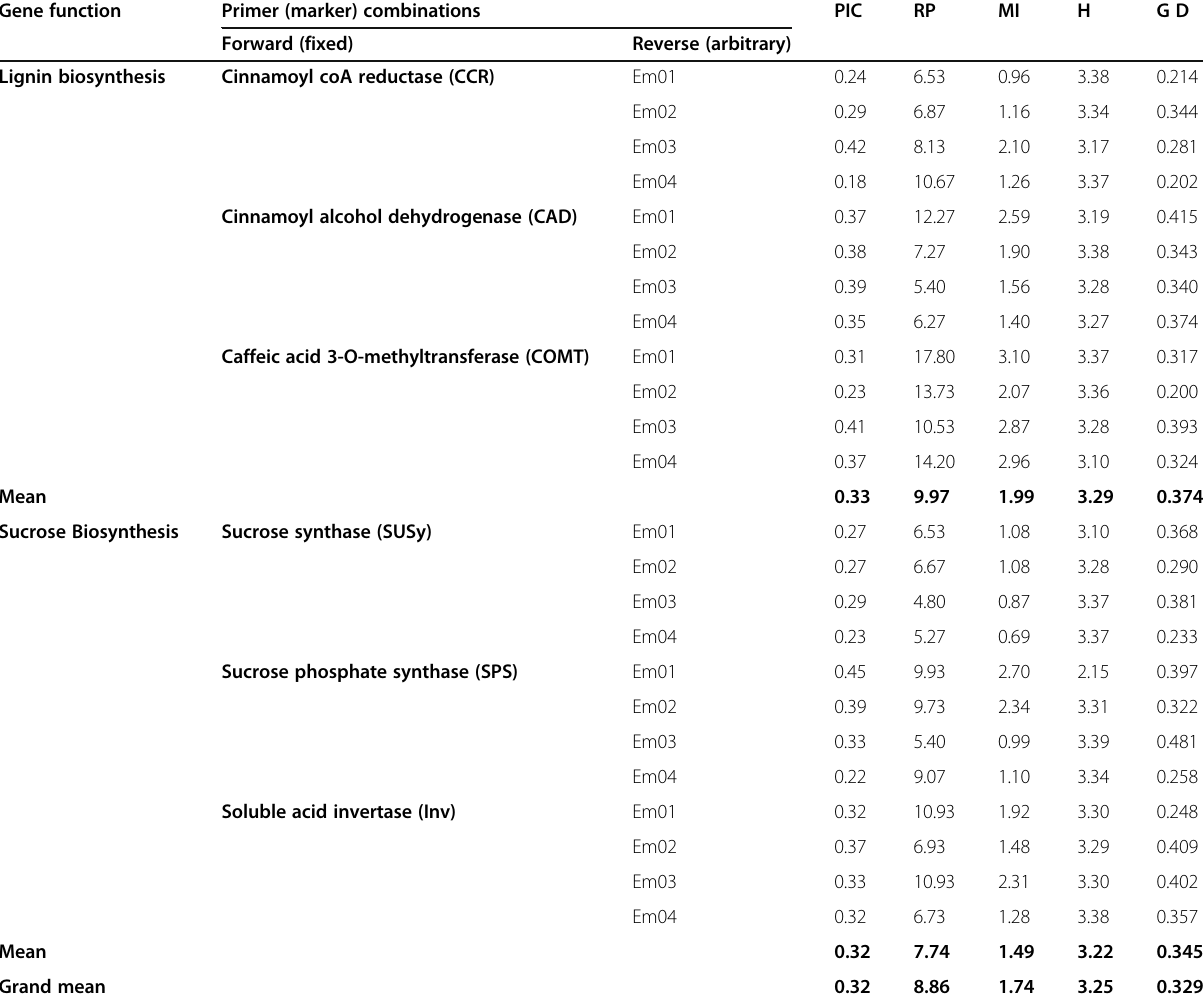
Table 4 TRAP marker attributes and diversity indices of 30 sweet sorghum genotypes Gene function Primer (marker)